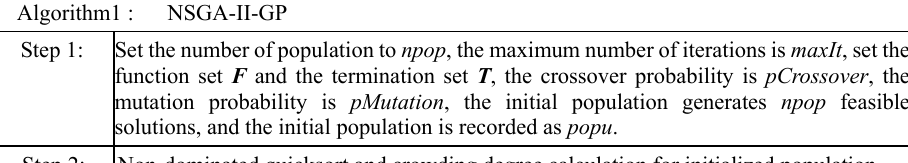
Table 1. NSGA-II-GP